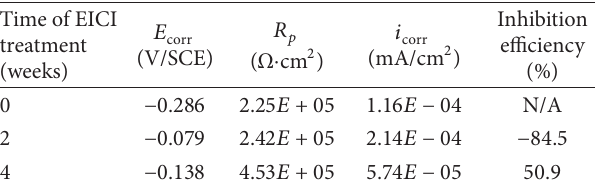
Table 5: 𝐸 corr , 𝑅 𝑝 , and 𝐼 corr values obtained from the weak polar- ization tests for uncontaminated samples with or without EICI treatment in sodium borate solution.